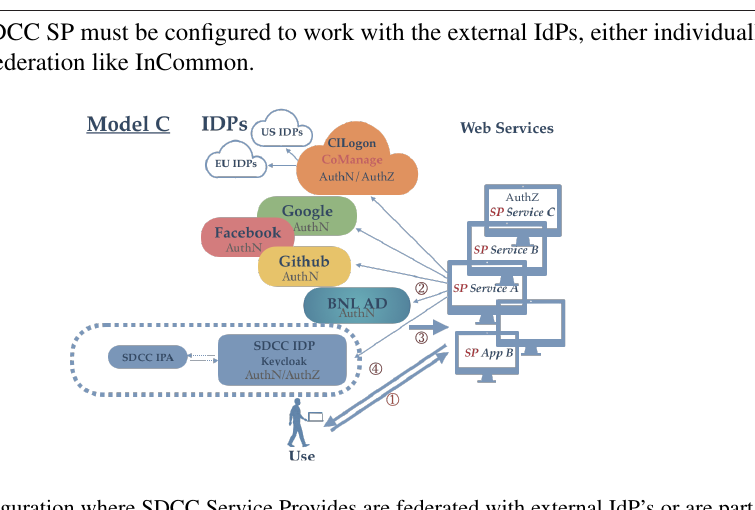
Figure 2. Configuration where SDCC Service Provides are federated with external IdP’s or are part of a federation organization like InCommon.